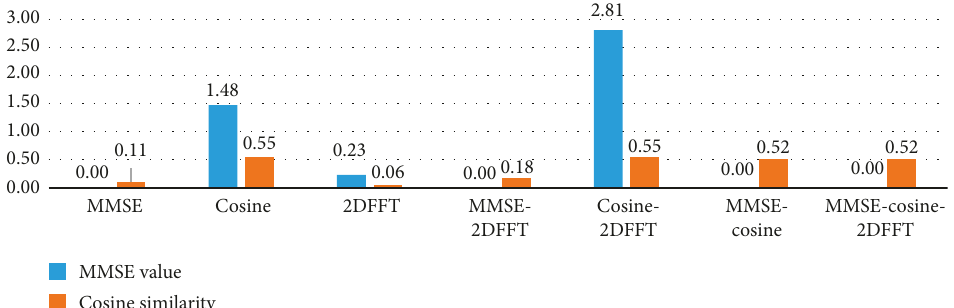
Figure 7: MMSE value and cosine similarity evaluation results of 7 kinds of loss function corresponding to test set. Unlike the loss function of the cosine similarity, the similarity value here is the similarity coefficient distributed in [− 1 , 1 ] , where 1 represents completely similar and − 1 represents completely opposite.